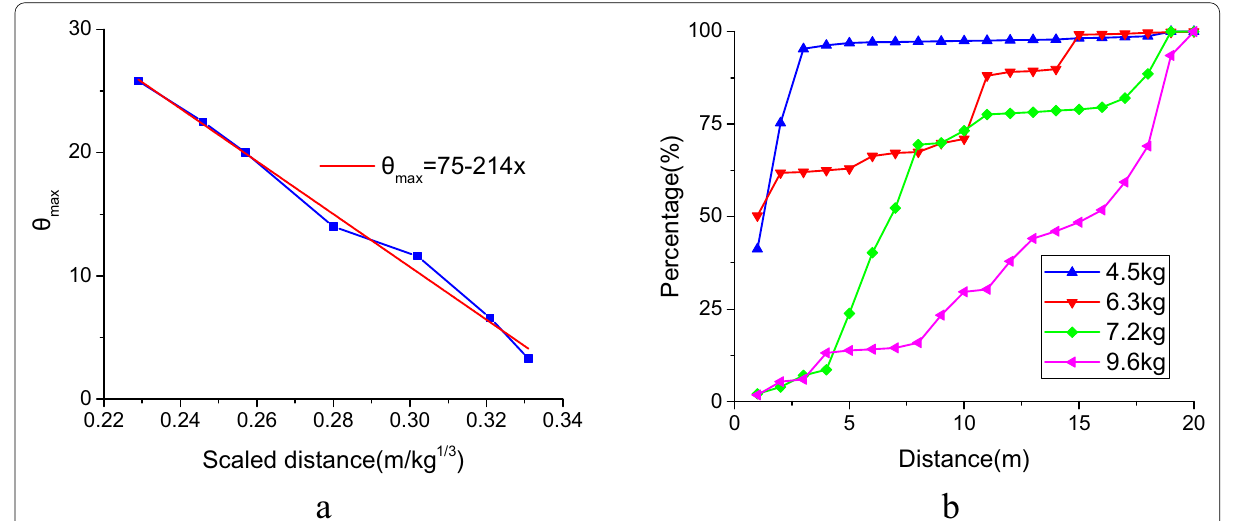
Fig. 18 The law of FC05 slab’s fragments: a the relationship between horizontal angle and scaled distance and b the relationship between fragment percentage and